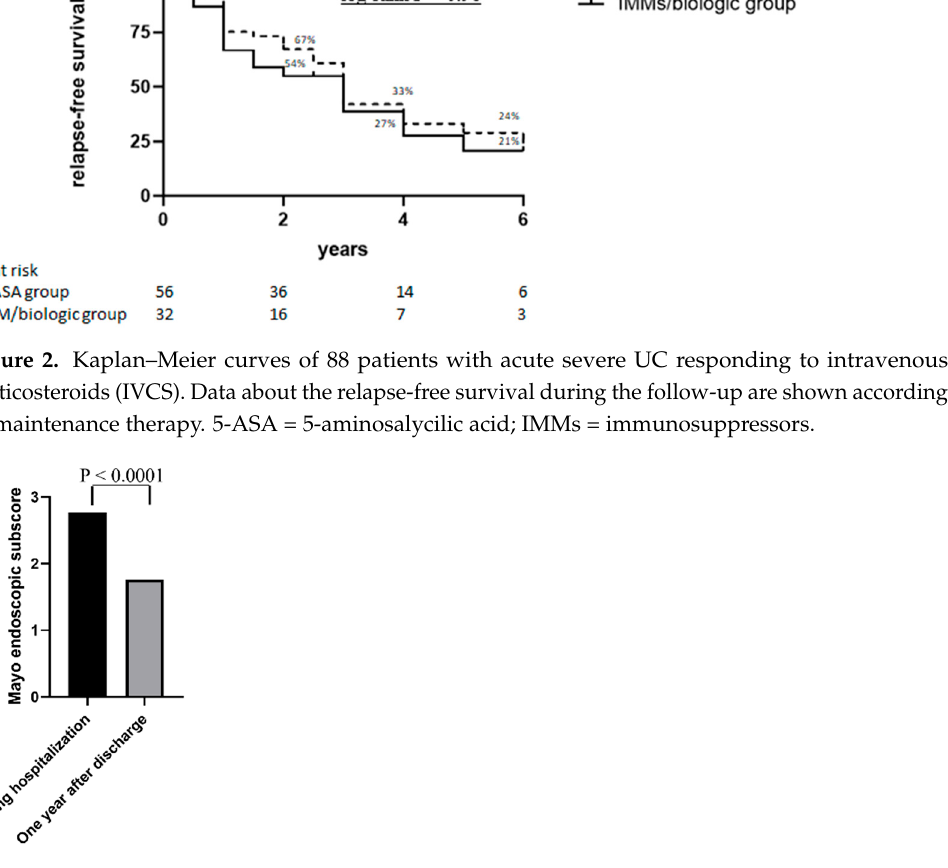
Figure 3. Mayo endoscopic sub-scores at the time of hospitalization and one year after discharge in 47 patients responding to intravenous corticosteroids (IVCS) and receiving 5-aminosalycilic acid (5-ASA) or immunosuppressors/biologics as maintenance therapy.